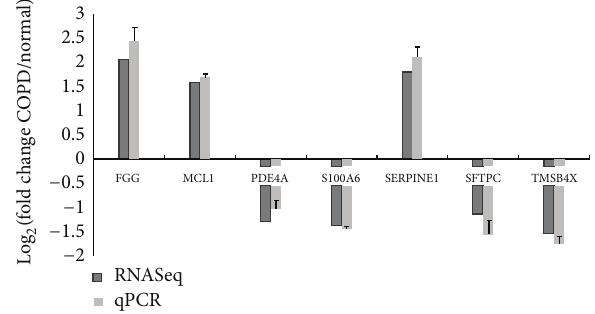
Figure 3: RNA-seq and quantitative real-time PCR results of seven genes. Results of fold change by two methods are